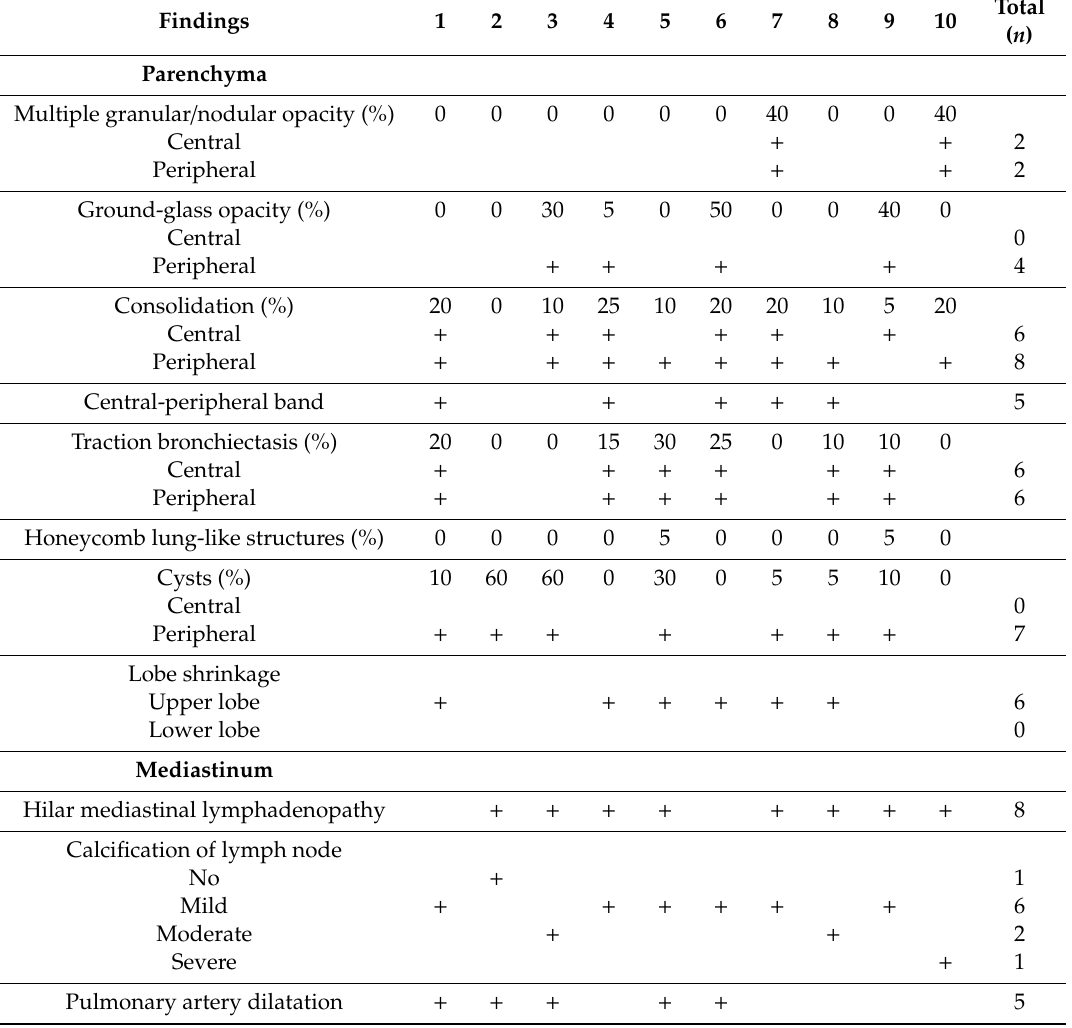
Table 4. CT findings at the time of first CT ( n =